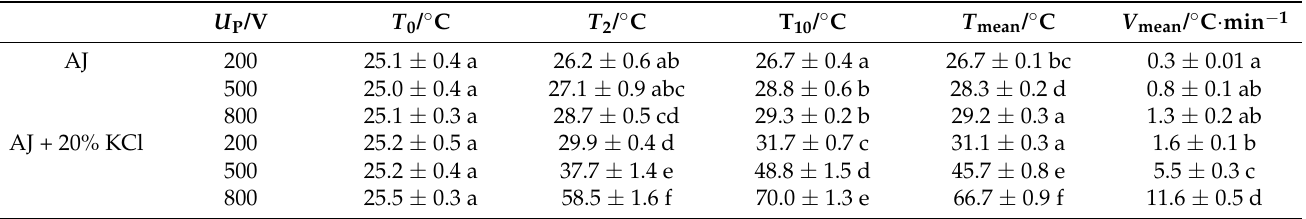
Table 2. Variation of temperature with excitation voltage at 400 Hz, d 1 = 2 mm, L 1 = 10 cm, N S = 2 ×